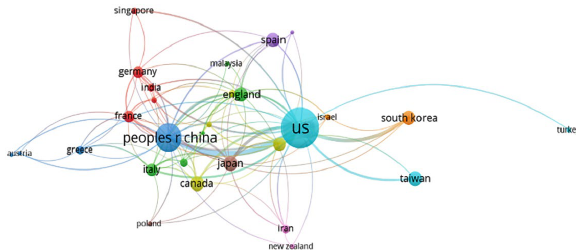
Figure 8. The collaboration network at level of country/region